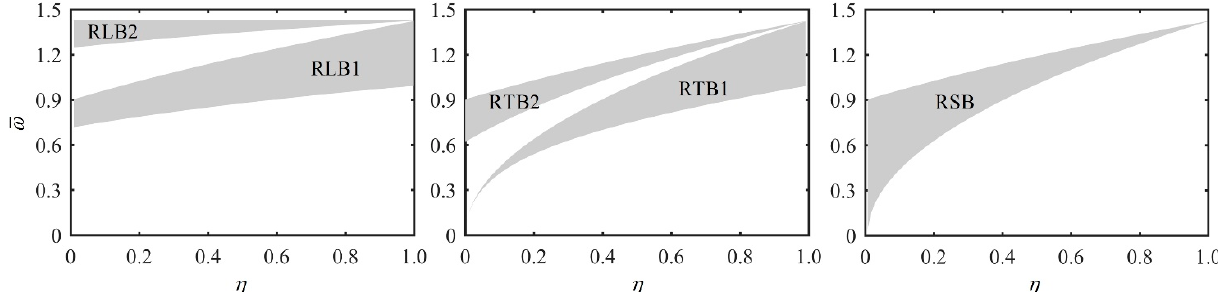
η : longitudinal waves ( left ), trans-